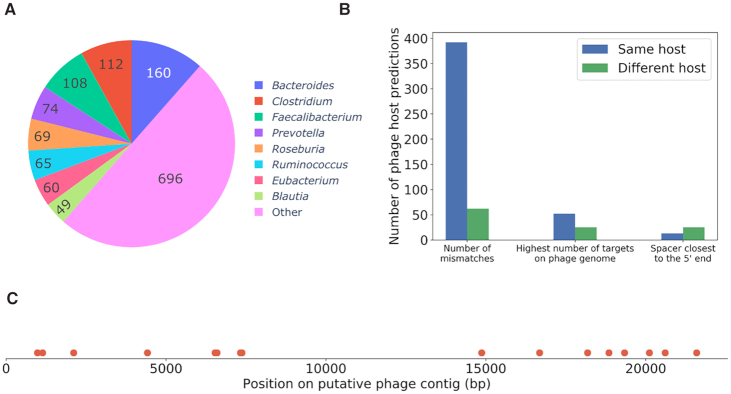
Bacterial host predictions for unknown phages from the gut virome. Eight dominant members of the gut microbiota represent half of the predictions. (A) Number of phages predicted to infect each bacterial genus. (B) Number of predictions obtained from each filter for gut virome phages when a host was also predicted in the previous Shkoporov study. Predictions that are identical or different to the Shkoporov study are in blue and green, respectively. (C) Regions (red dots) on a putative Clostridium-infecting phage contig targeted by Clostridium spacers.